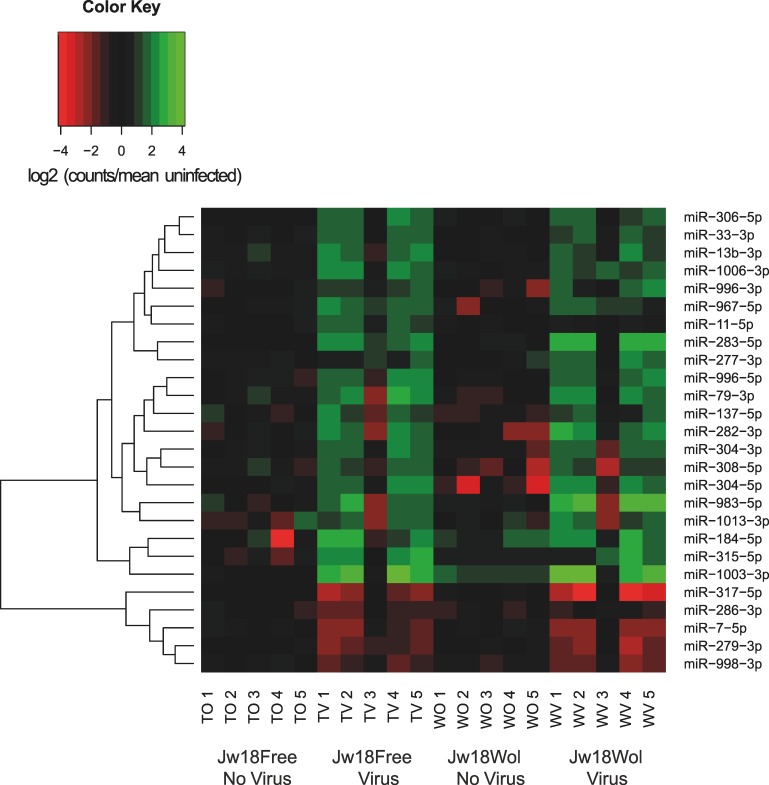
The effect of Wolbachia on D. melanogaster miRNA expression in the presence or absence of virus.Heatmap showing the effects of Wolbachia and SFV4(3H)-RLuc virus on miRNA abundance. The mean of the No Virus-No Wolbachia treatment is set to zero. Only miRNAs that are significantly (Adjusted p value<0.1, Negative Binomial Test) differentially expressed in at least one treatment are shown. Jw18Wol replicate WV 3 was included in analysis; although it appeared to be an outlier as its inclusion did not alter the significance of the data. T = Jw18Free, W = Jw18Wol, V = SFV infection, O = no SFV infection and numbers represent replicate.